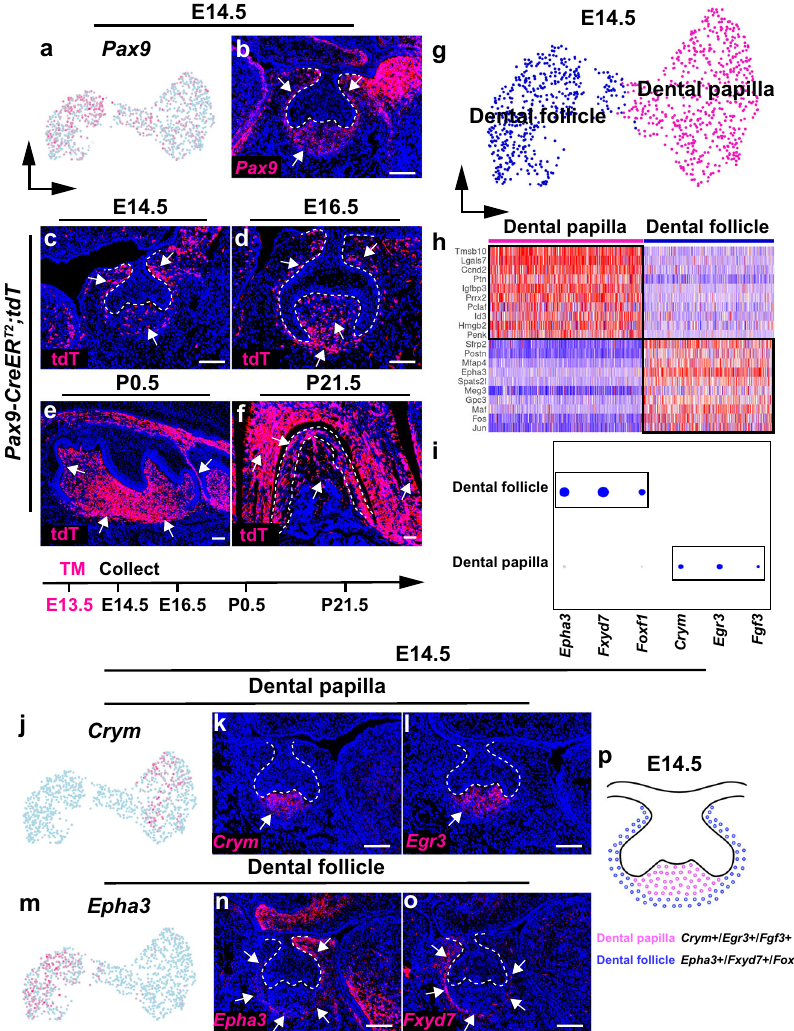
Fig.2|DentalfollicleanddentalpapillalineagessegregateatE14.5.a , b Feature plotandRNAscopestainingof Pax9 inthemousemolaratE14.5( n =3). c – f Lineage tracing analysisof Pax9+ cellsin the dental mesenchyme of the mouse molar from E14.5toP21.5( n =3). g UMAPplotofthedentalmesenchymeinthemousemolarat E14.5. h , i Heatmap and Dotplotof signaturegenes inthe dentalpapilla and follicle of the mouse molar at E14.5. j – l Feature plot and RNAscope staining of dental